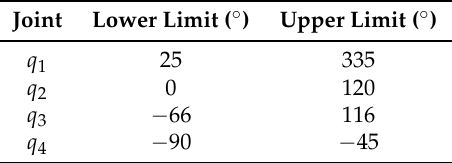
Table 1. Range for the joints of the manipulator.